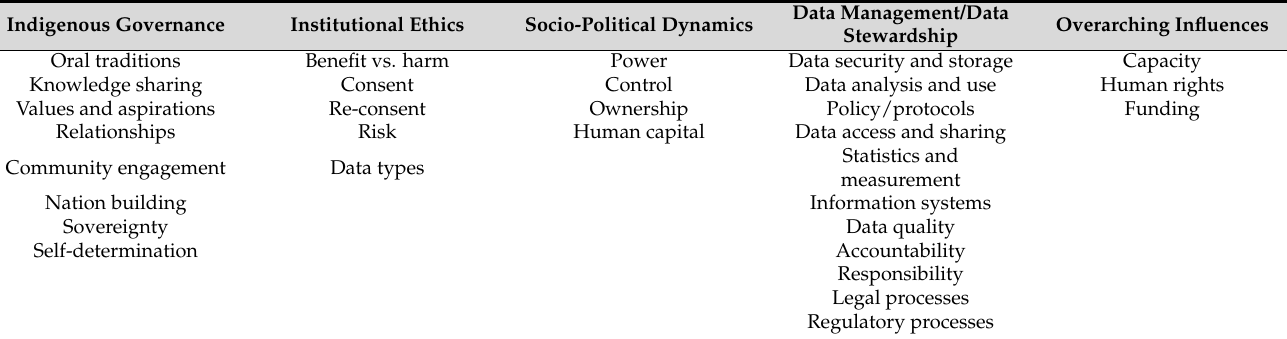
Table A1. Policies, processes and practices as necessary to